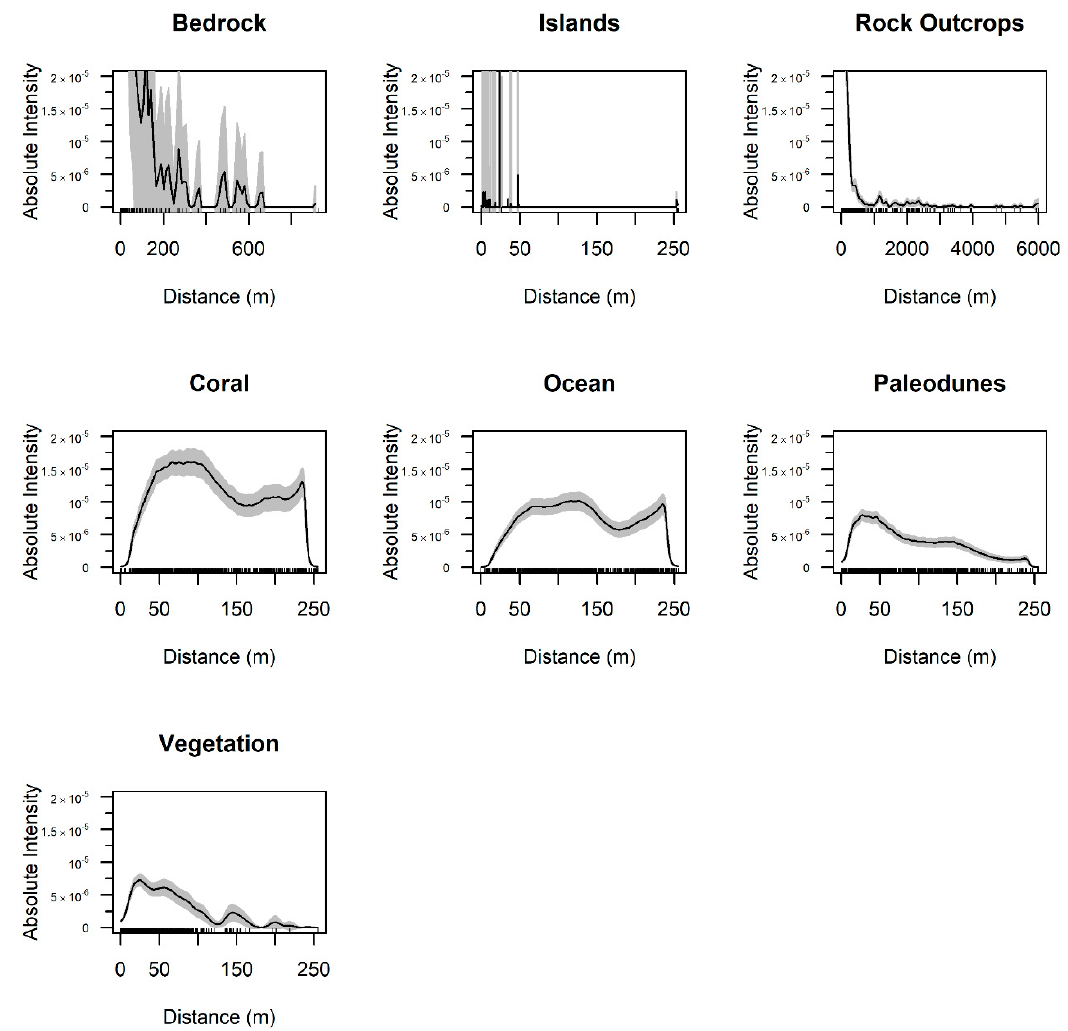
Figure 4. First order intensity of archaeological deposits (per m 2 ) as a function of different environmental variables using nonparametric smoothing (rho-hat test). Euclidian distance measurements were used for distance (m) calculations.